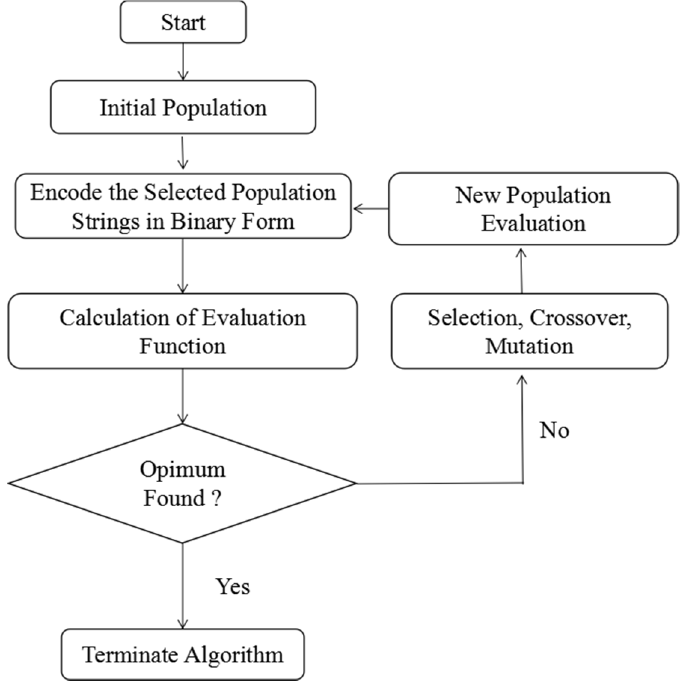
Figure 3. Flow diagram of genetic algorithm (GA).